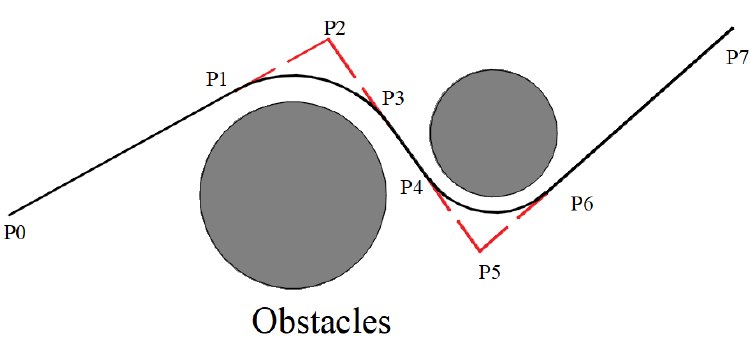
Figure 8. Optimized angle.